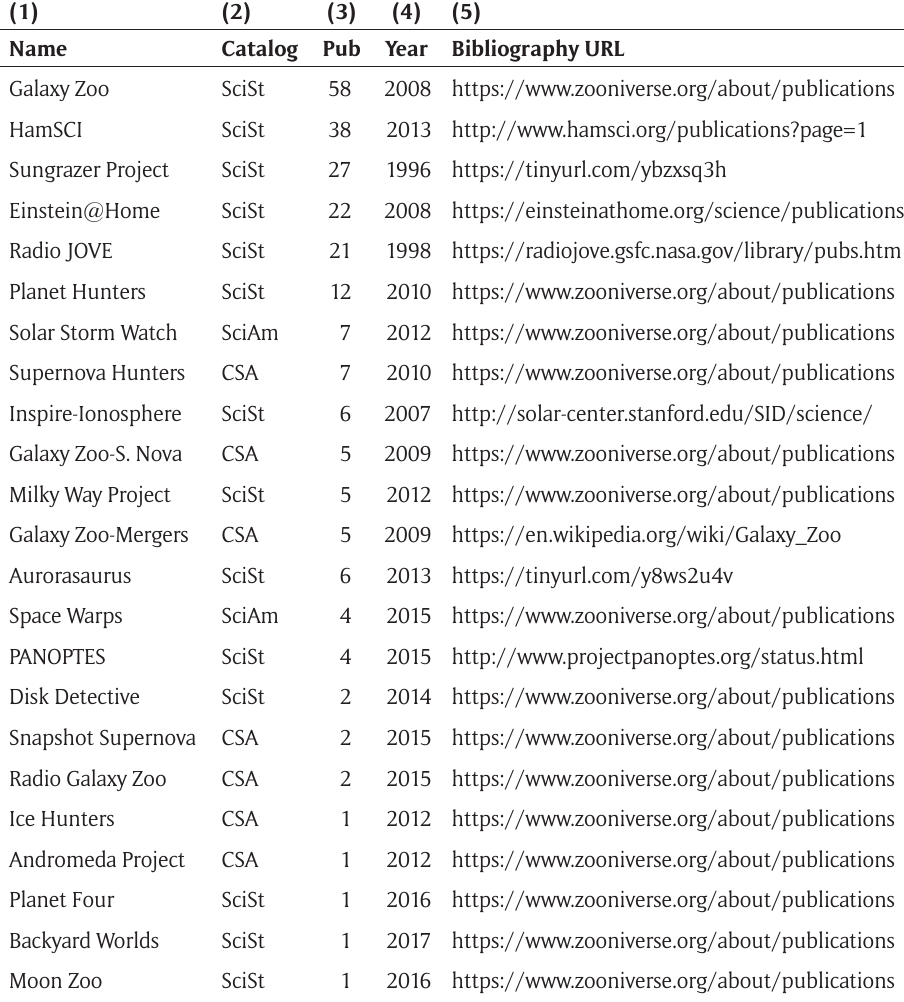
Table 1: Citizen science projects in space science and astronomy with published